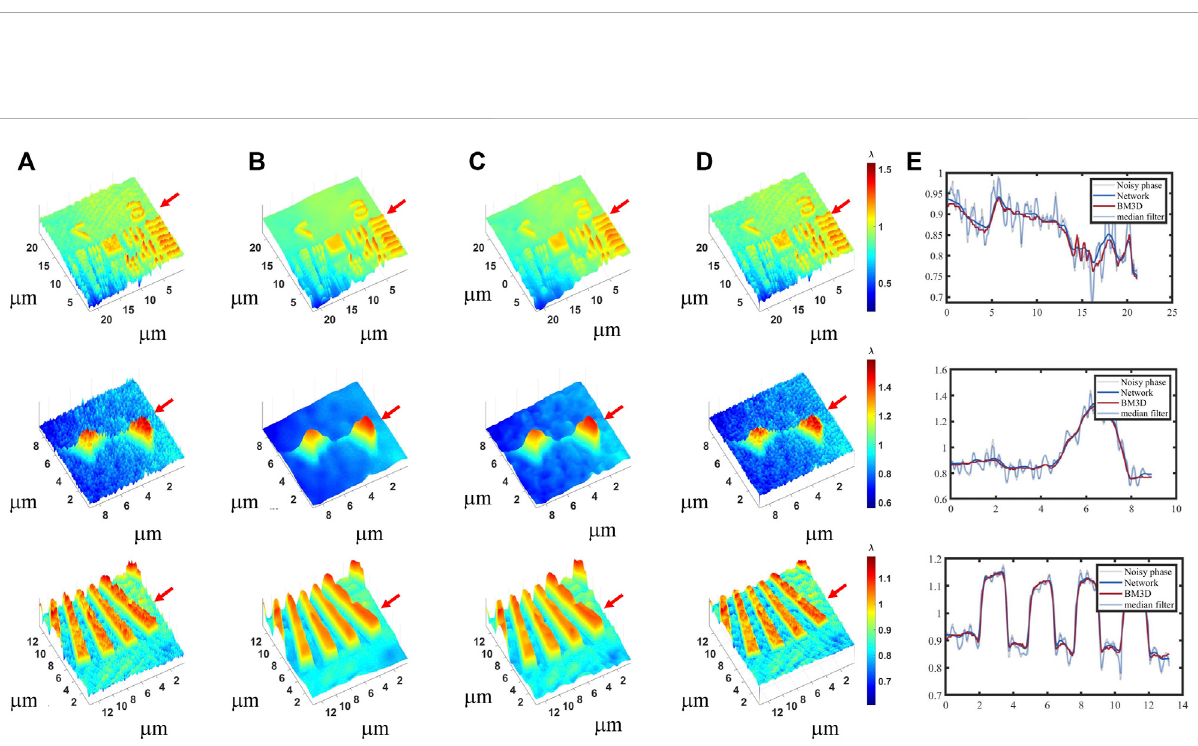
FIGURE 4 Comparison of noise suppression results on cell phase. The upper and lower rows are different cells. (A) The phase images of the resolution board, HT22 cell and line board; (B) The noise suppression phase by the network; (C) The noise suppression phase by median fi lter in a 6-by- 6 neighborhood; (D) The noise suppression phase by BM3D with noise variance of 0.02; (E) The pro fi le map along with the red at the red